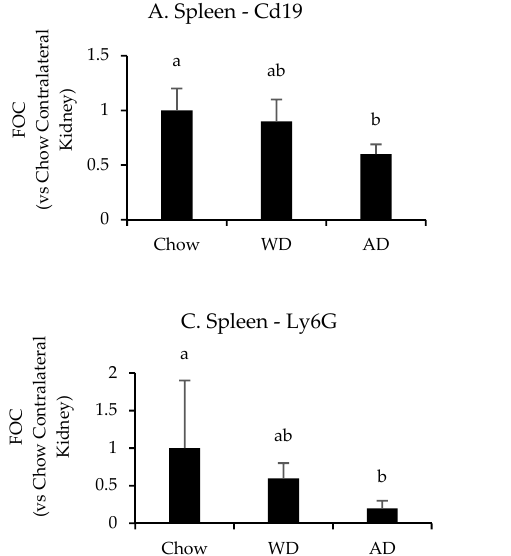
Figure 6. Splenic expression of leukocyte specific genes following uIRI. Data are presented normalized to chow-fed mice. Different superscript letters (a vs. b) signify significant difference between diets ( p < 0.05) as determined by Two-Way ANOVA with Tukey Post Hoc test. Treatments with similar superscript letters are not statistically different ( p > 0.05). RT-PCR data and statistics are presented in Appendix G Table A5. n = 4–6 for each diet-treatment combination. FOC—fold change.